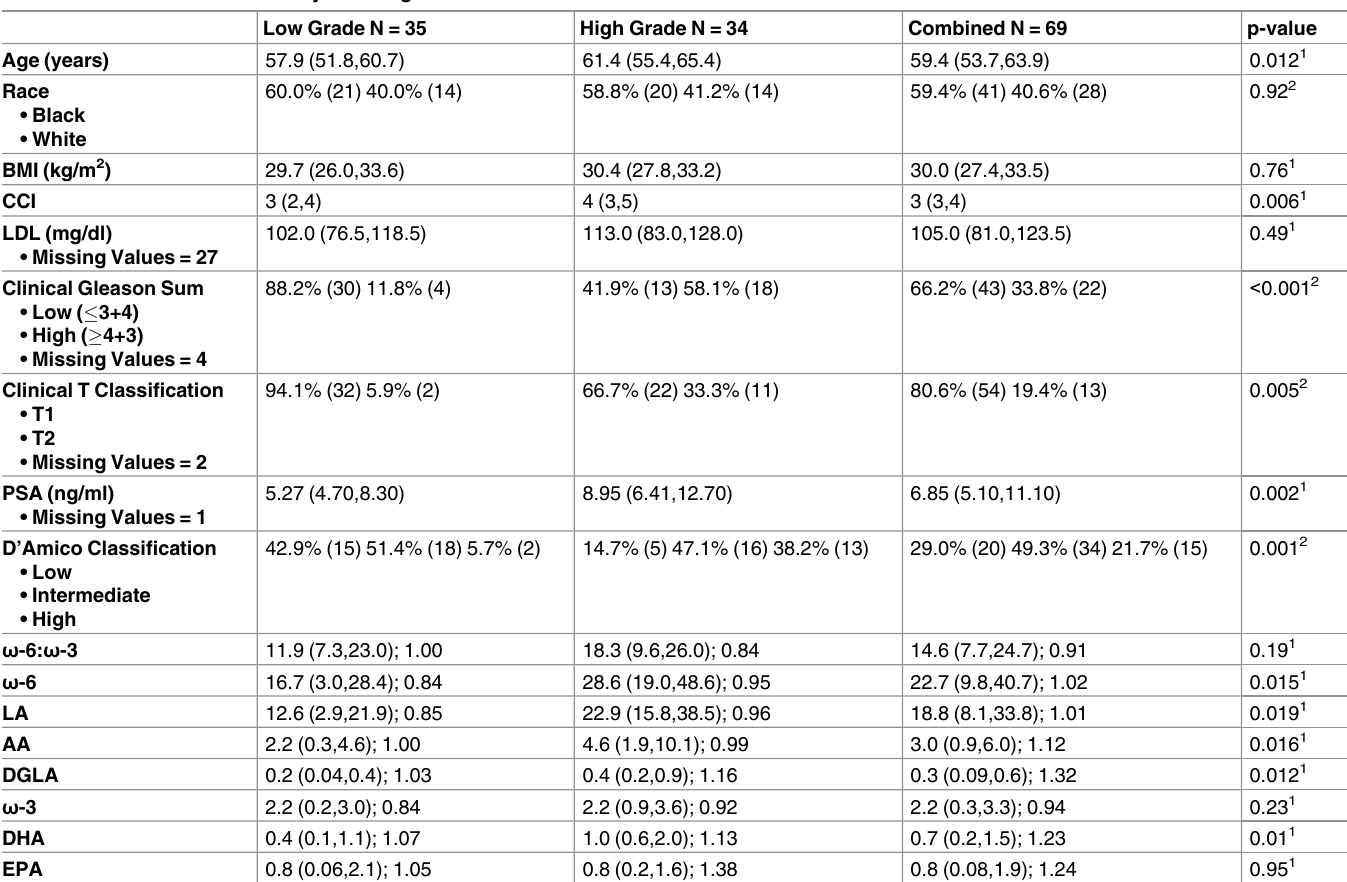
Table 1. Patient Characteristics by Pathological Gleason